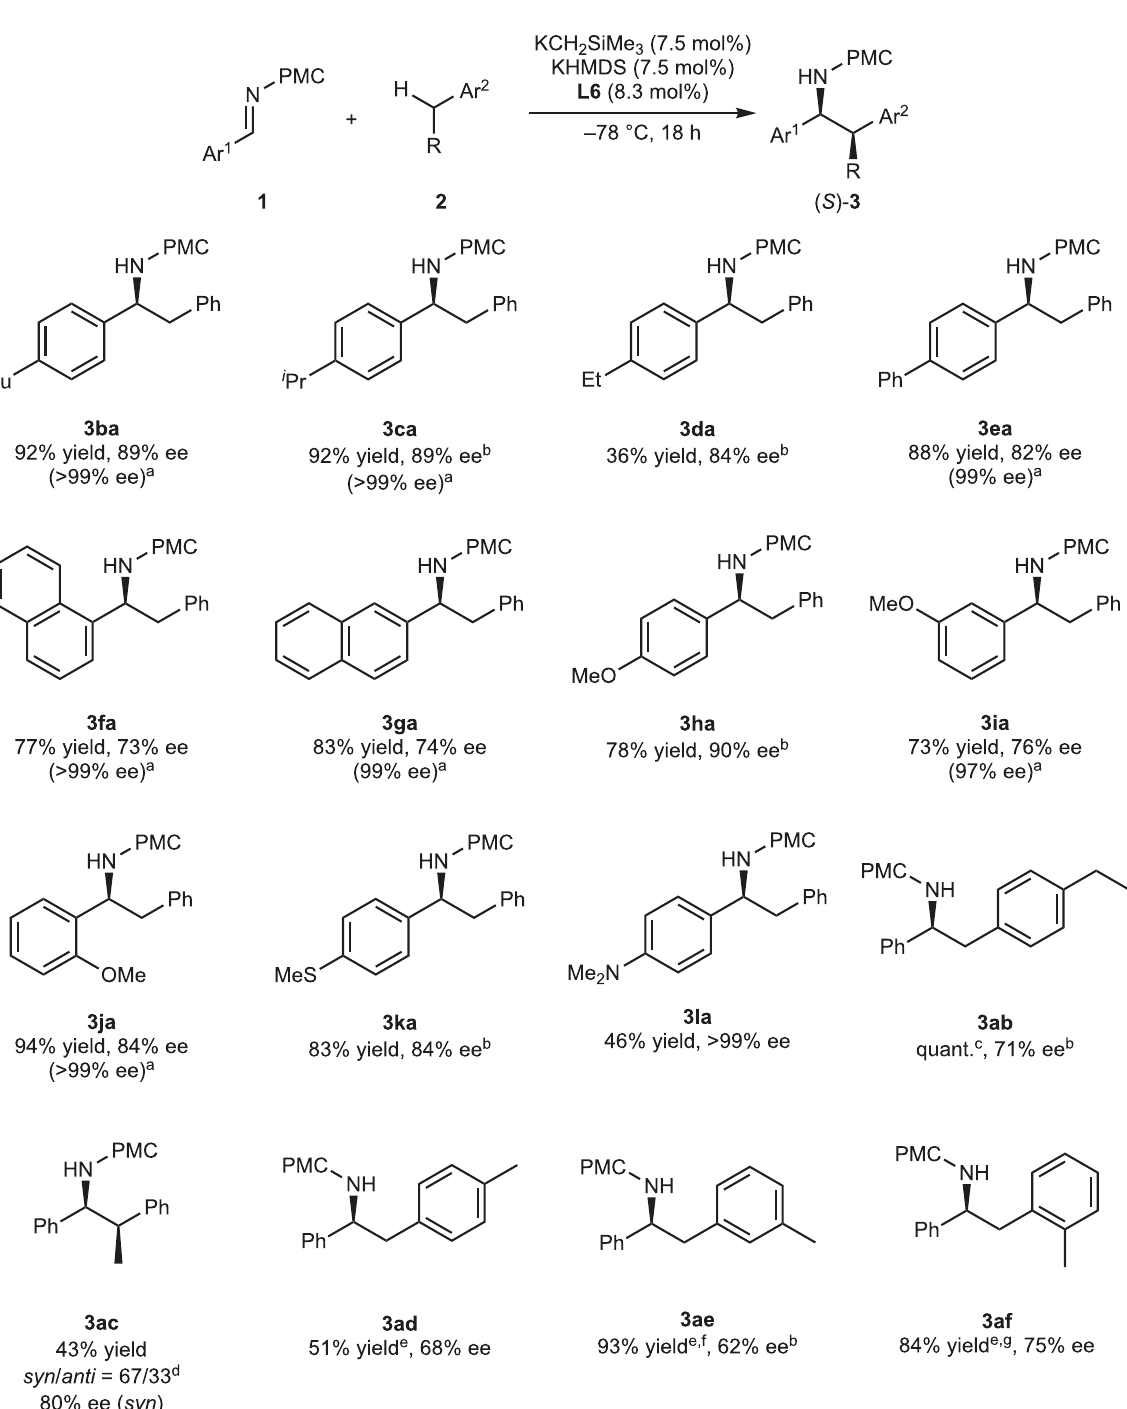
Fig. 1 Scope of the reaction with respect to imines. Reaction conditions: 1 (1.0 mmol), 2 (2.0 mL), KCH 2 SiMe 3 (0.075 mmol), KHMDS (0.075 mmol), L6 (0.083 mmol), − 78 °C, 18 h. a After recrystallization. b The enantiomeric excess was determined after transformation into the corresponding free amine. c At − 70 °C for 65 h. d The relative con fi guration of the product shown in the table is de fi ned as syn . e Reaction conditions: 1 (0.50 mmol), 2 (2.5